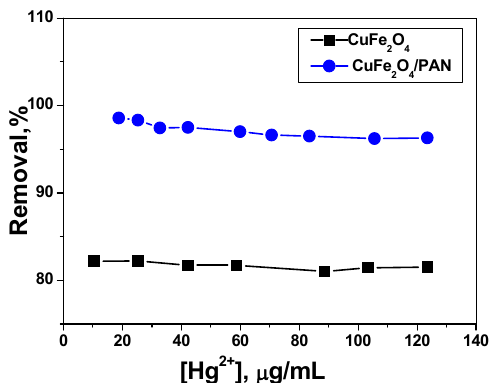
Figure 4. Effect of Hg 2+ concentration on adsorption optimization using CuFe 2 O 4 and CuFe 2 O 4 /PANI Figure 4. E ff ect of Hg 2 + concentration on adsorption optimization using CuFe 2 O 4 and CuFe 2 O 4 / PANI nano-composites sorbents; Conditions: (V= 30 mL, contact time = 2 h for CuFe 2 O 4 and 1 h for nano-composites sorbents; Conditions: (V = 30 mL, contact time = 2 h for CuFe 2 O 4 and 1 h for CuFe 2 O 4 / PANI, adsorbent amount = 0.1 g CuFe 2 O 4 and 0.2 g CuFe 2 O 4 / PANI and pH CuFe 2 O 4 /PANI, adsorbent amount =0.1 g CuFe 2 O 4 and 0.2 g CuFe 2 O 4 /PANI and pH 7).